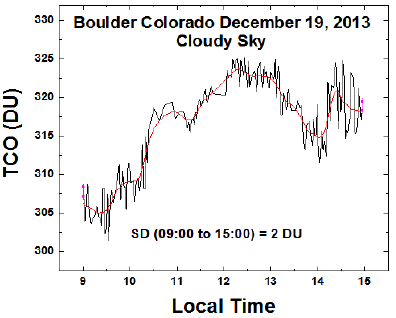
Figure 12. Pandora-retrieved TCO under cloudy conditions as shown in Fig. 7 and a Lowess(0.2) fit (red curve) to the TCO data.